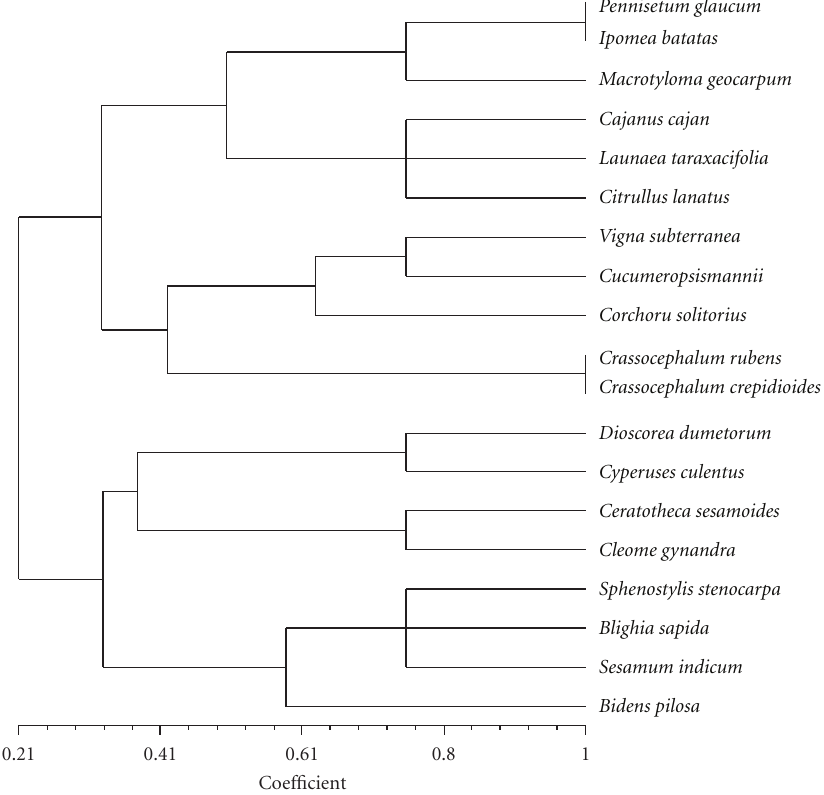
Figure 6: UPGMA dendrogram showing di ff erent grouping of the species based on the four most used evaluation criteria. Africans in general and Beninese in particular su ff er or die of malnutrition in the midst of a great diversity of highly nutritive food crops by ignorance or